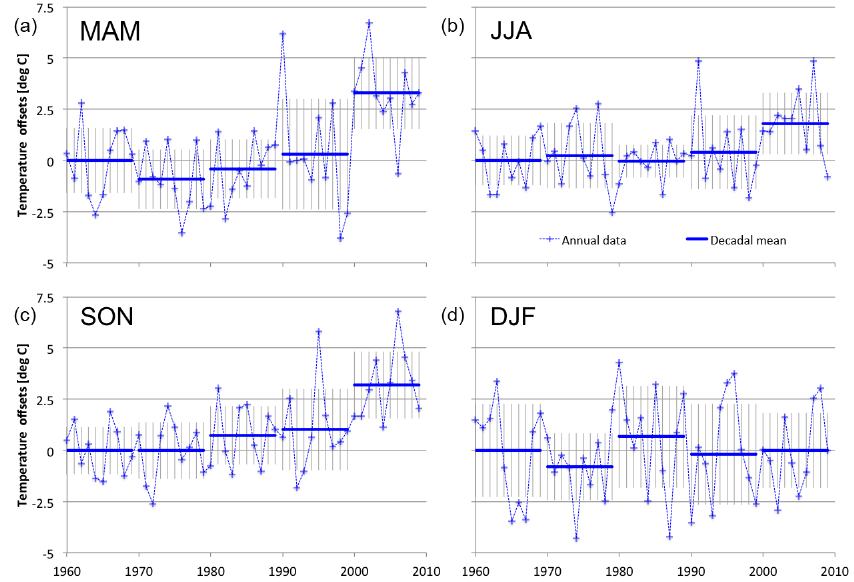
Figure 3. Temperature trends for the Chersky station, taken from the BEST database. (a) Springtime warming period; (b) core summer period; (c) fall freeze-up period; (d) core winter period. All temperatures were normalized against the mean seasonal temperatures from the 1960–1969 decade. Blue crosses and dashed blue lines give annual data, and thick blue lines the decadal mean with vertical grey bars showing decadal RMSE.